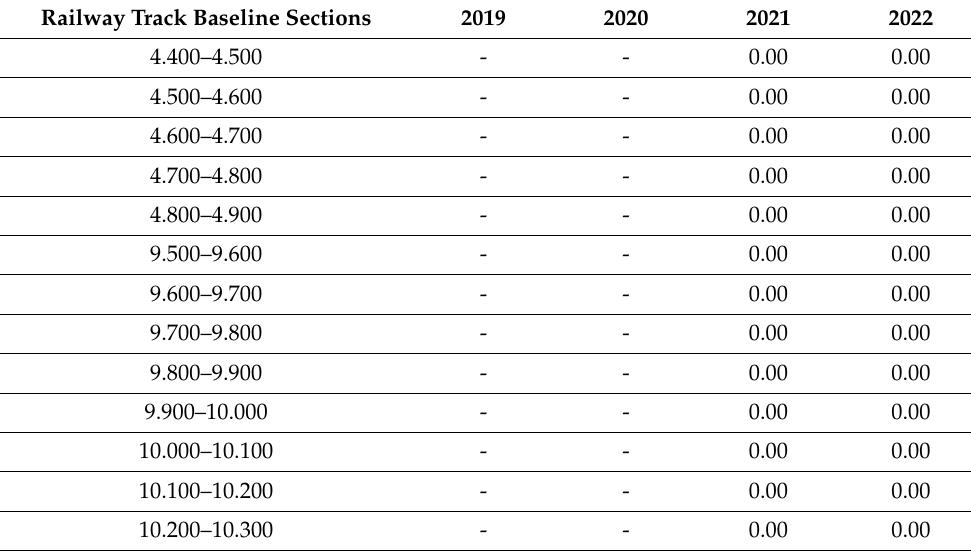
Table A10. Estimates of the railway track condition—relative D 5 object No. R 161_2. Railway Track Baseline Sections